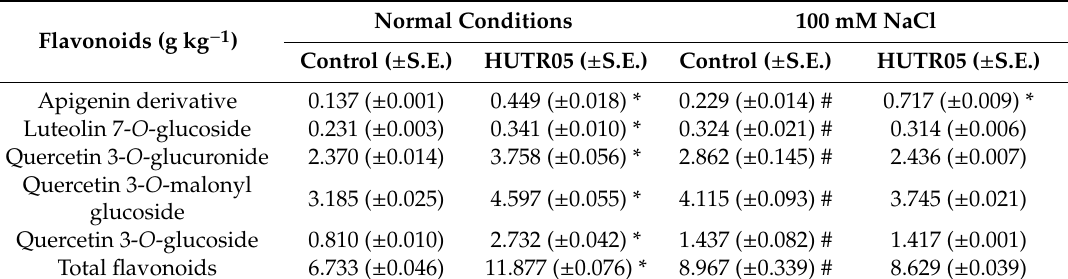
Table 4. Flavonoid content (g kg − 1 ) of control lettuce plants and plants inoculated with Rhizobium laguerreae